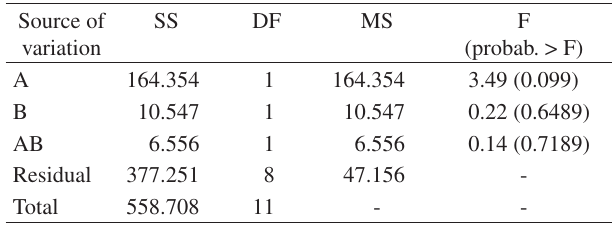
Table 5. Analysis of variance (ANOVA) results. Table 4. Results of compressive strength.